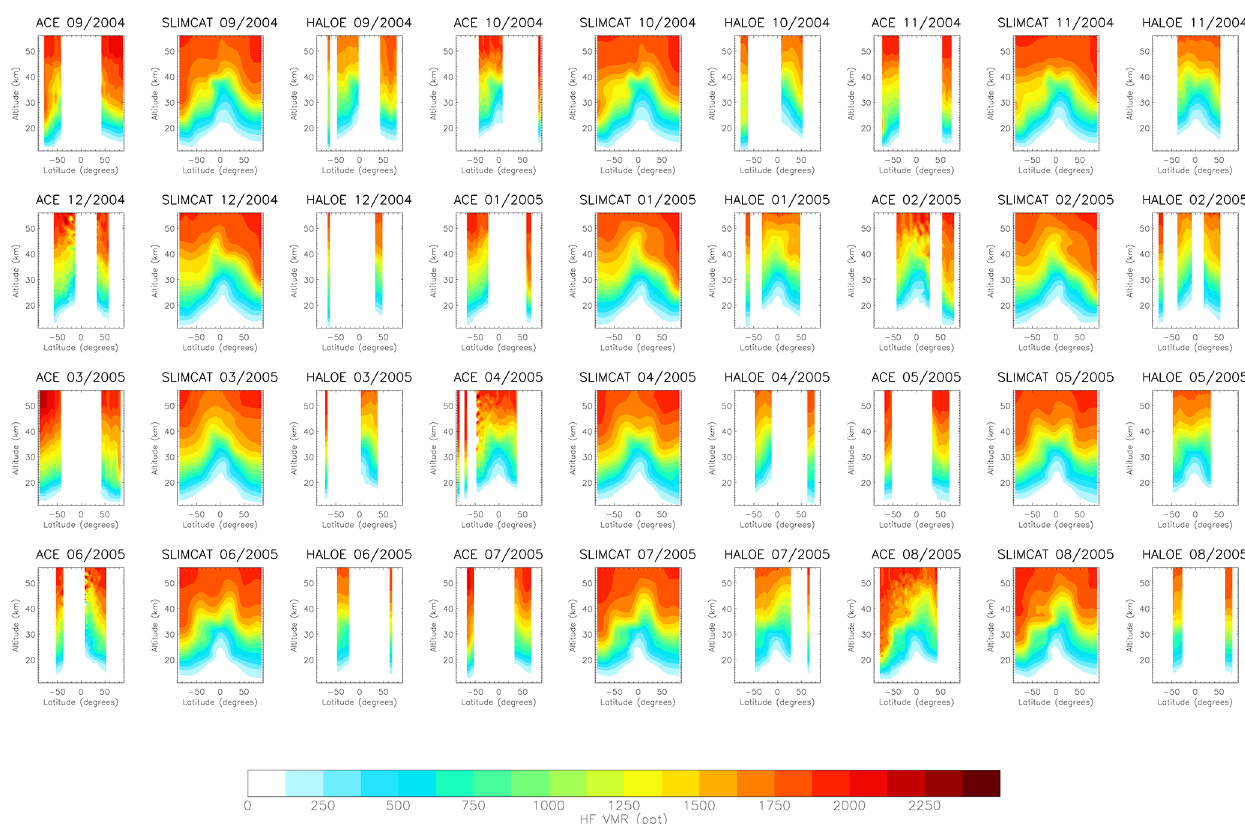
Figure 2. A comparison between ACE-FTS, HALOE, and SLIMCAT HF zonal means (September 2004 to August 2005). The ACE-FTS and HALOE time series of measurements overlap during the period January 2004 to November